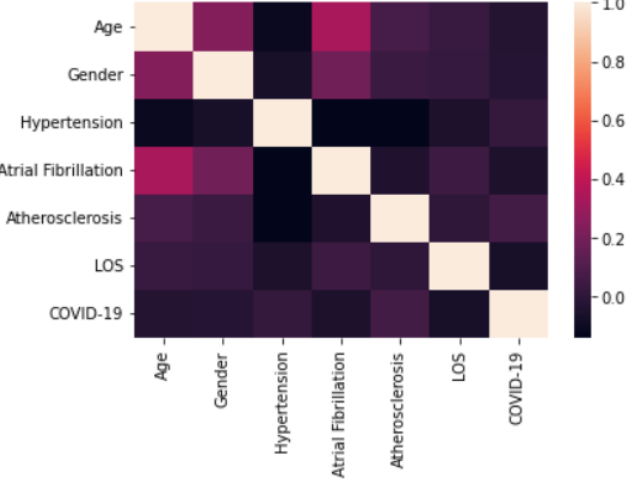
Figure 12. Correlation analysis.